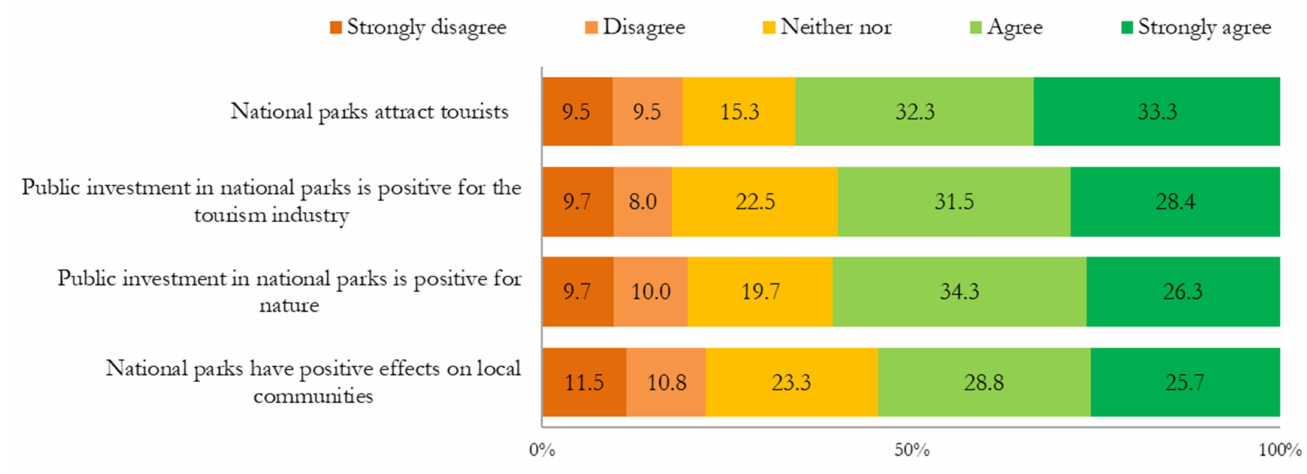
Figure 9. Tourism companies’ attitudes towards statements about national parks’ utility. Table 3. Analysis of tourism companies’ statements about national parks’ utility based on whether the companies use the Central Highlands (CH) for their operations or